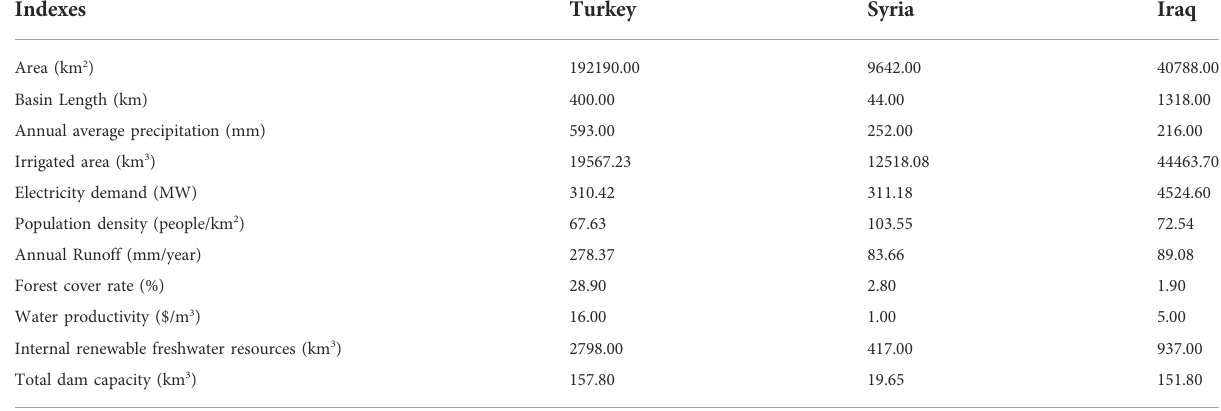
TABLE 4 The water circumstances data of the three countries.